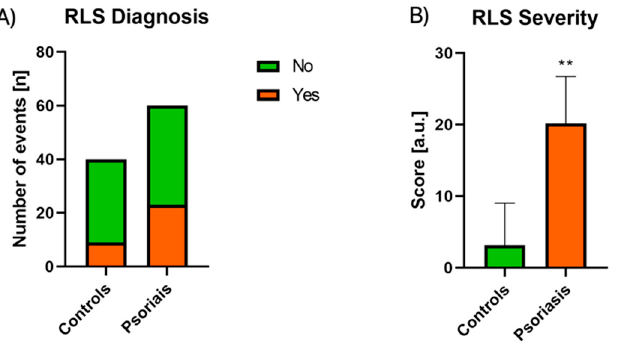
Figure 5. Assessment of frequency ( A ) and severity of RLS ( B ) in psoriatics and control groups. Graph B presents data shown as Mean ± SD and values are normally distributed. **—means the existence of a statistically significant difference between values treatment with p < 0.01. RLS, restless legs syndrome. Data are shown as Mean ± SD or Contingency Graph.